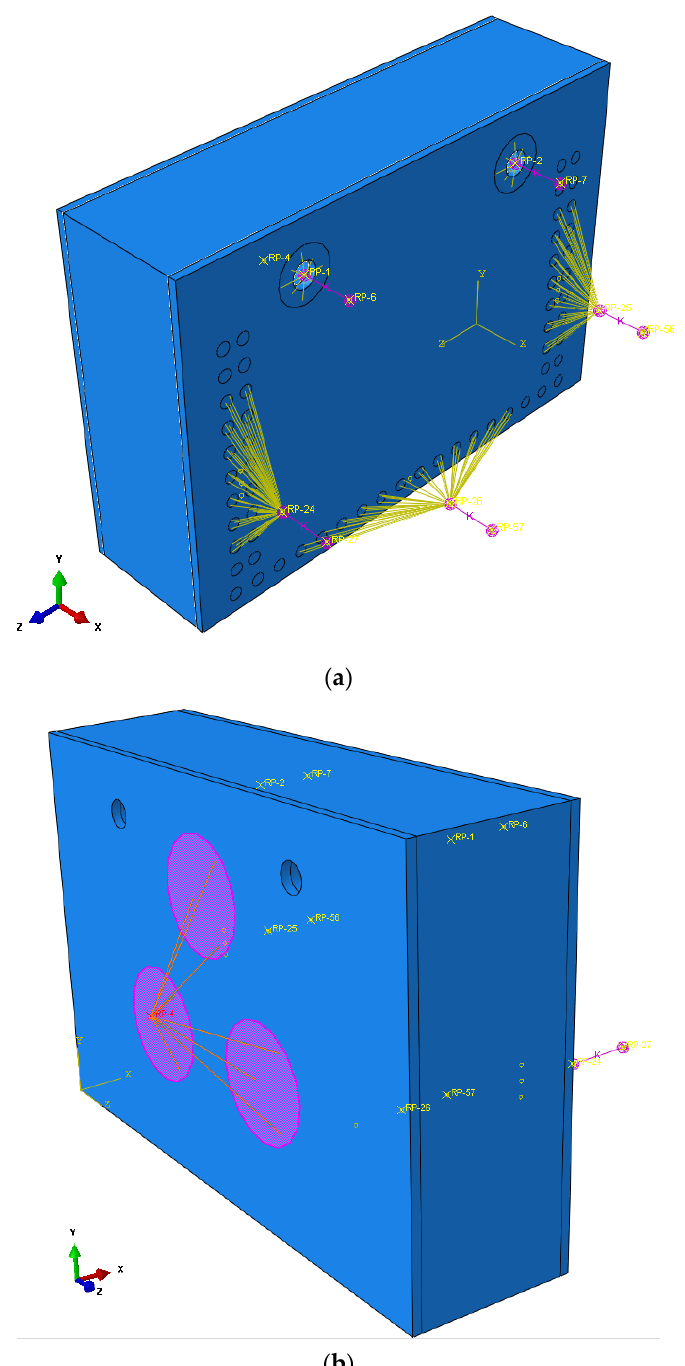
Figure 13. Spring nodes (coupling) for ( a ) front side and ( b ) rear side.